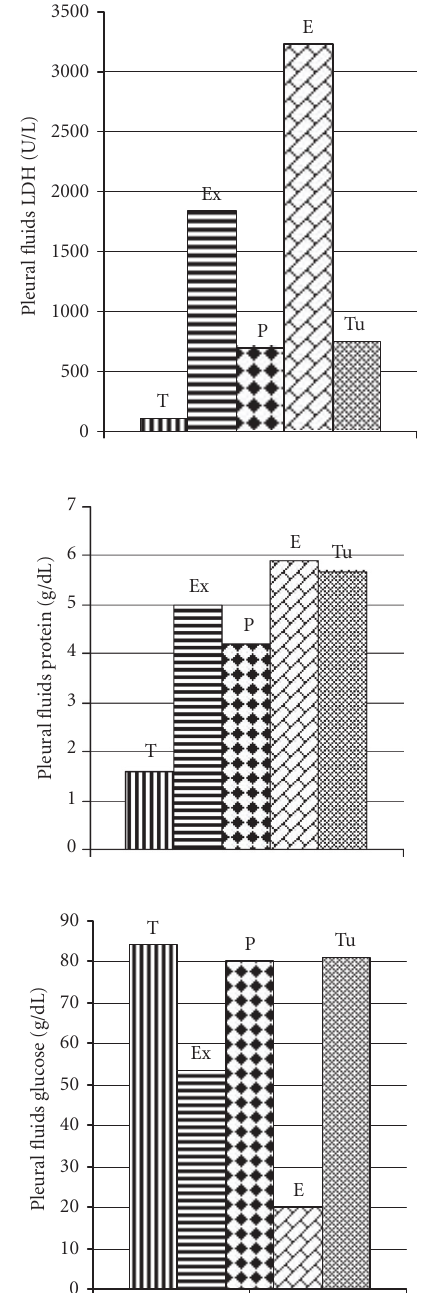
Figure 3. The levels of pleural fluids biochemical characteristics in the study groups.